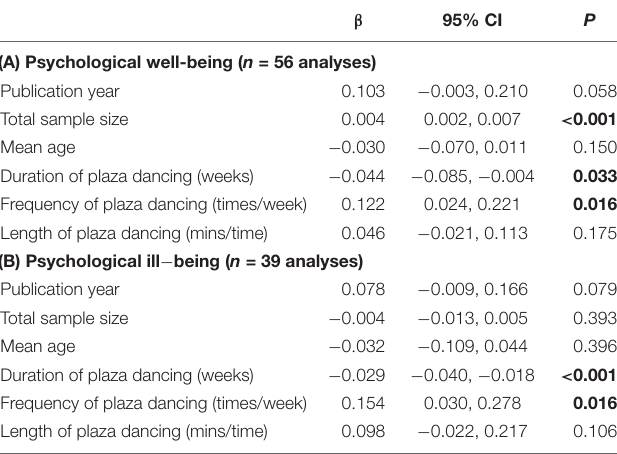
TABLE 3 | Results of meta-regression analyses on the association between plaza dancing and psychological well-being and ill-being. β 95% CI